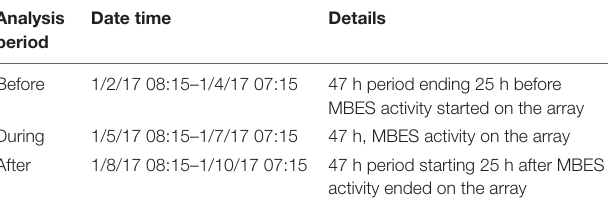
TABLE 2 | Analysis period times and details of the 2017 data set.